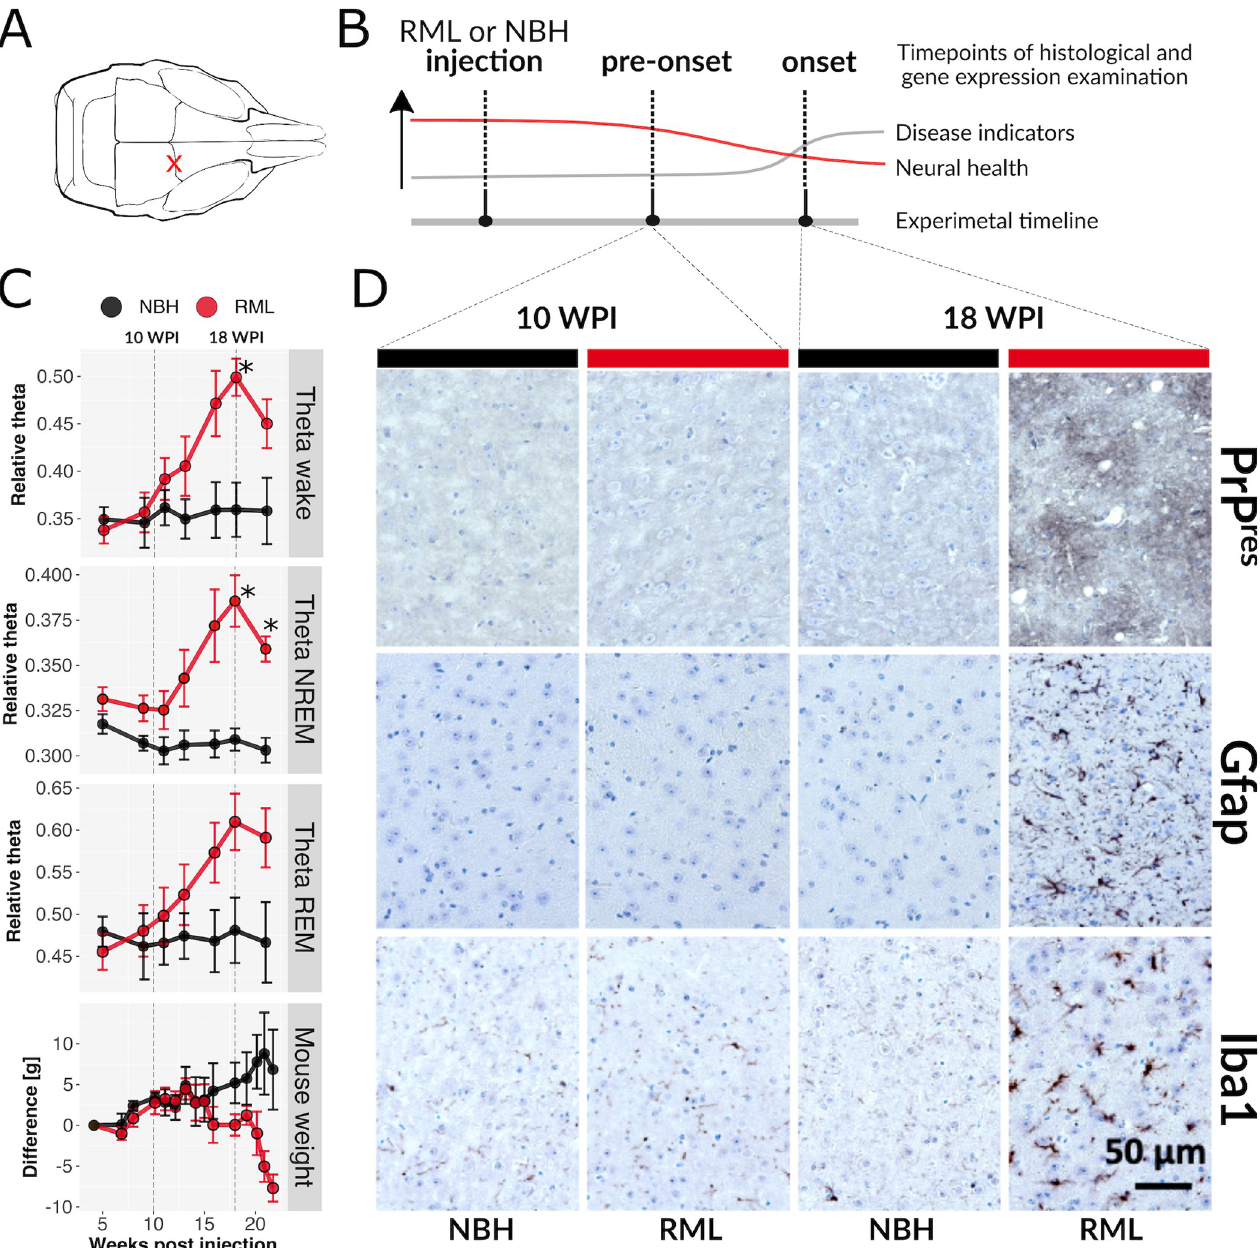
Fig 1. Gradual increase in EEG theta power and histopathological changes in RML. ( A ) Location of RML and NBH injections, marked by a red X. ( B ) Conceptual experimental timeline for collection of tissues for translatome and histopathological analysis, in relation to disease progression. At the pre-onset stage mice appear normal and lack disease indicators, but neural health begins to decline. ( C ) Summarized EEG theta power of wake (top), NREM sleep (second from top) and REM sleep (third from top) mice injected with RML (red) or NBH (black) juxtaposed with weekly percentage body weight measurement (expressed as deviation from initial weight) of the same mouse cohorts (bottom). Two-factor mixed ANOVA tests demonstrate significant difference in all four measurements (respectively: F [6,48] = 8.9, p-value < 0.001; F [6,48] = 6.9, p-value < 0.001; F [6,48] = 8.3, p-value < 0.001; F(14,98) = 4.8, p-value < 0.001). Differences were significant (p-value � 0.05, Holm-Sˇı´da´k test) at 18 WPI for wake and NREM and at 21 WPI for NREM (marked by � ). ( D ) Immunohistochemistry staining of thalamus of RML infected and control (mice injected with NBH) 4 μ m thick formalin fixed paraffin embedded brain sections at 10 and 18 WPI. Staining with SAF84 prion protein antibody (brown) after proteinase K treatment to detect aggregated PrP (PrP res , top row), staining with GFAP antibody (dark brown) to detect astrogliosis (middle row) and staining with Iba1 antibody (dark brown) to detect microglia activation (bottom row). All sections were counterstained with hematoxylin. Spongiosis is apparent in the context of the intense SAF84 staining. Scale bar represents 50 μ m and applies to all images.